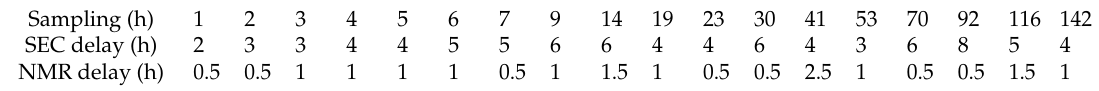
Table 6. Actual sampling schedule and measurement delays in the large-scale reactor.